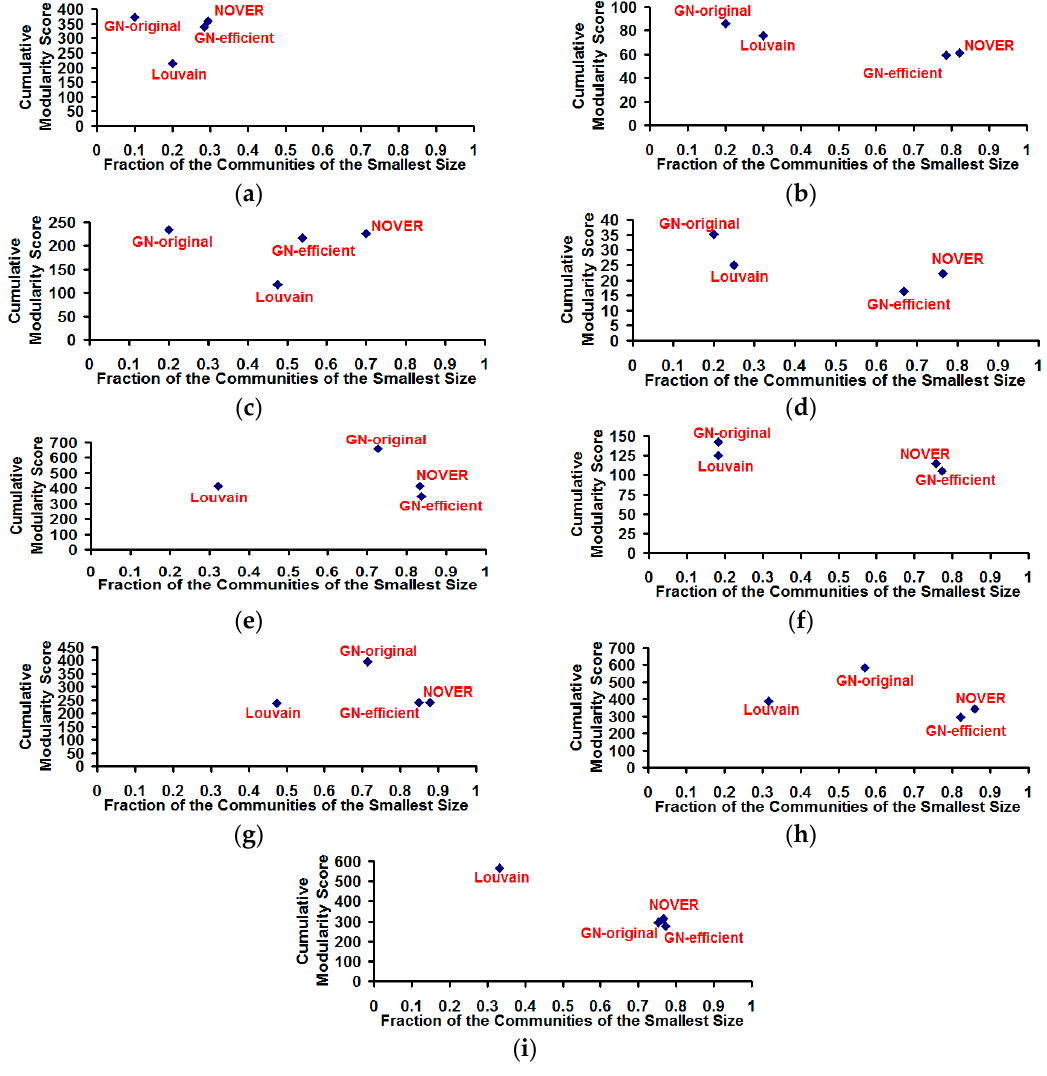
Figure 10. Cumulative modularity score vs. fraction of the communities of the smallest size for the community detection algorithms on real-world Network graphs. ( a ) US Football Network (FN); ( b ) Dolphin Network (DN); ( c ) US Politics Book Network (PN); ( d ) Karate Network (KN); ( e ) C. Elegans Network (NN); ( f ) Les Miserables Network (LN); ( g ) Citation GD Network (CN); ( h ) Erdos971 Collaboration Network (EN); ( i ) US Airports Network (AN).